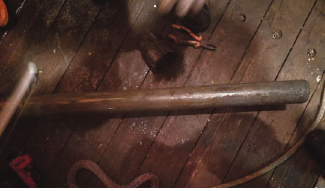
Figure 3: Sampling near HM-ROV-1. Some of the bright spots in the image are bubbles of gas hydrate.